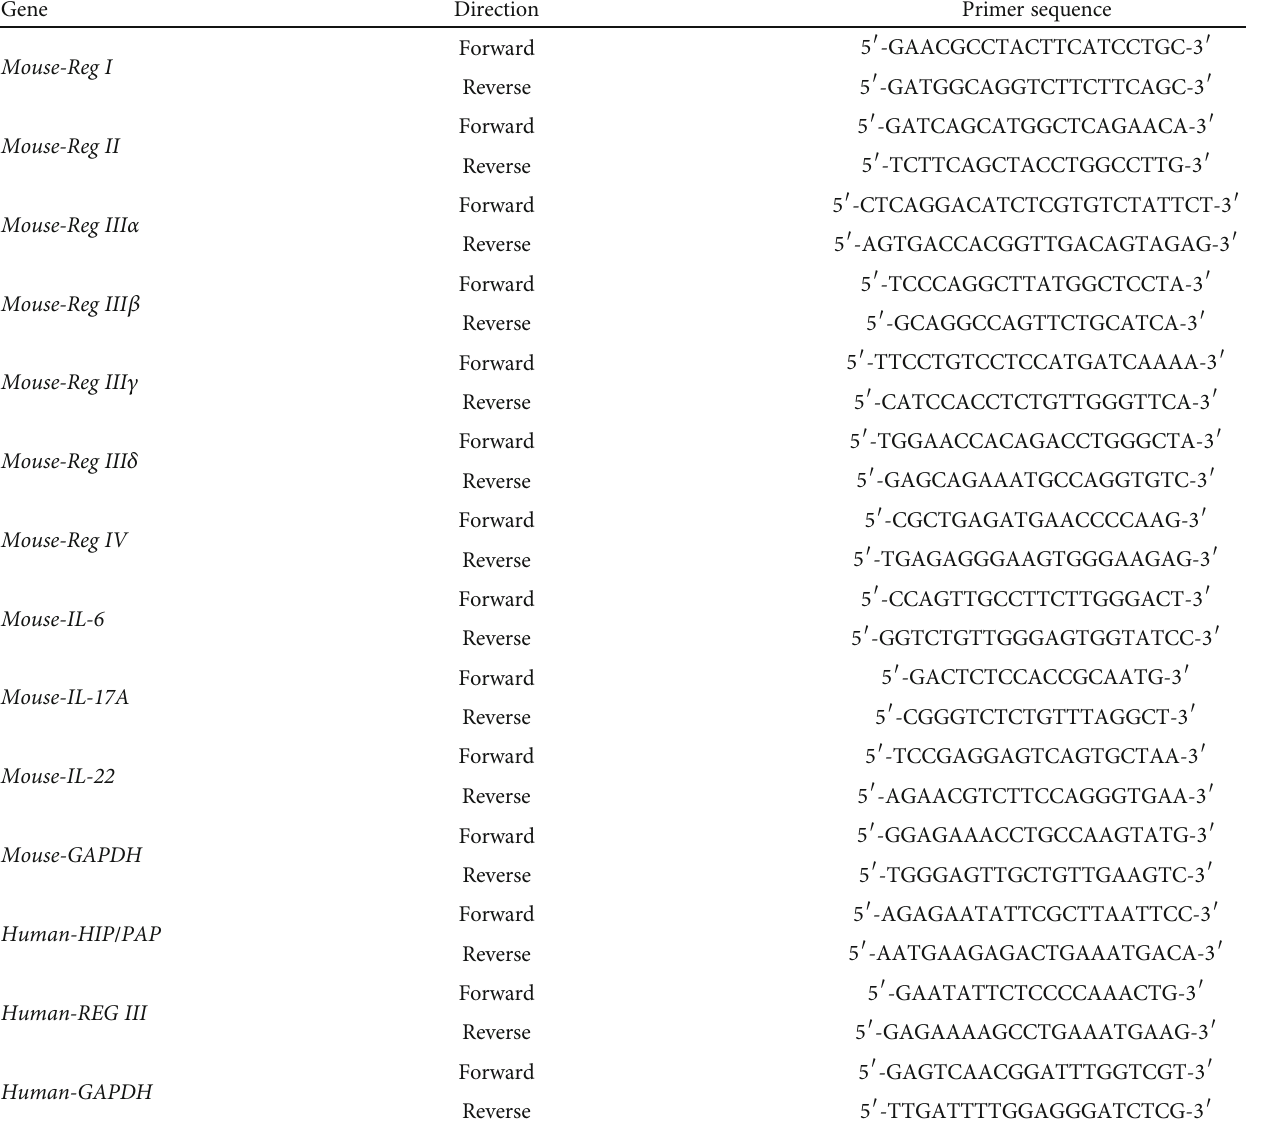
Table 1: Primers for real-time RT-PCR